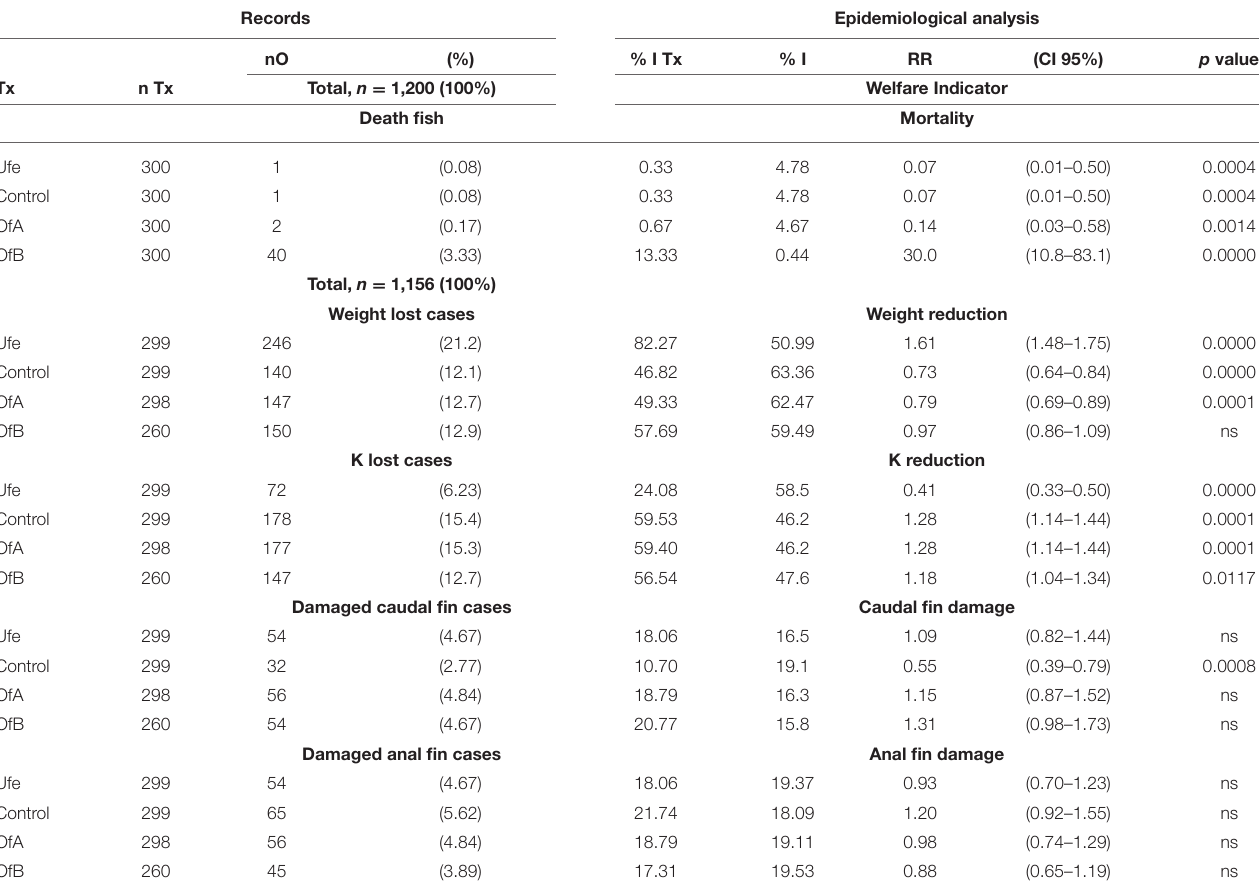
TABLE 6 | Contingency table, incidence of mortality, weight reduction, K reduction, and caudal and anal fin damage of on-growing 1 of O. niloticus according to the feeding